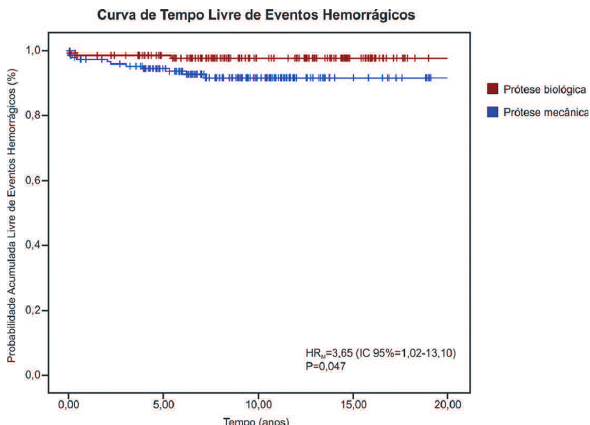
Fig. 3 - Curva de Kaplan-Meier para avaliar tempo livre de eventos Tabela 7. Preditores independentes de reoperação através da análise